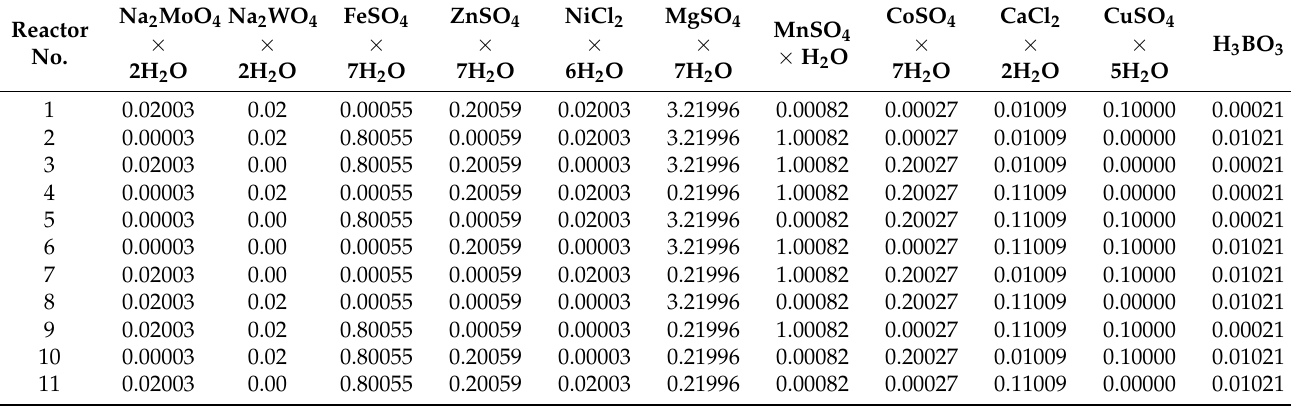
Table 2. Stock trace element concentrations presented in g/L in batch reactors after incorporating their presence from inoculum.